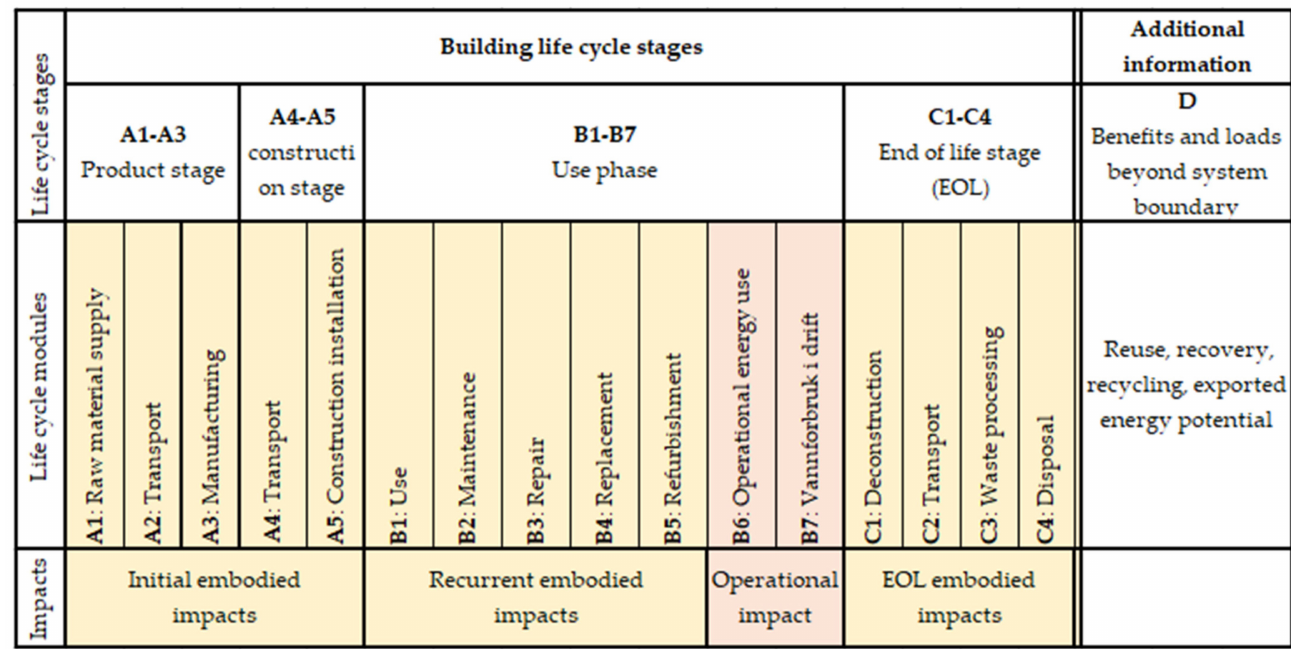
Figure 1. System boundaries in building LCA in relation to life cycle stages, modules, and types of impacts (embodied and operational). Adopted from EN 15978 [30] and Moncaster et al.